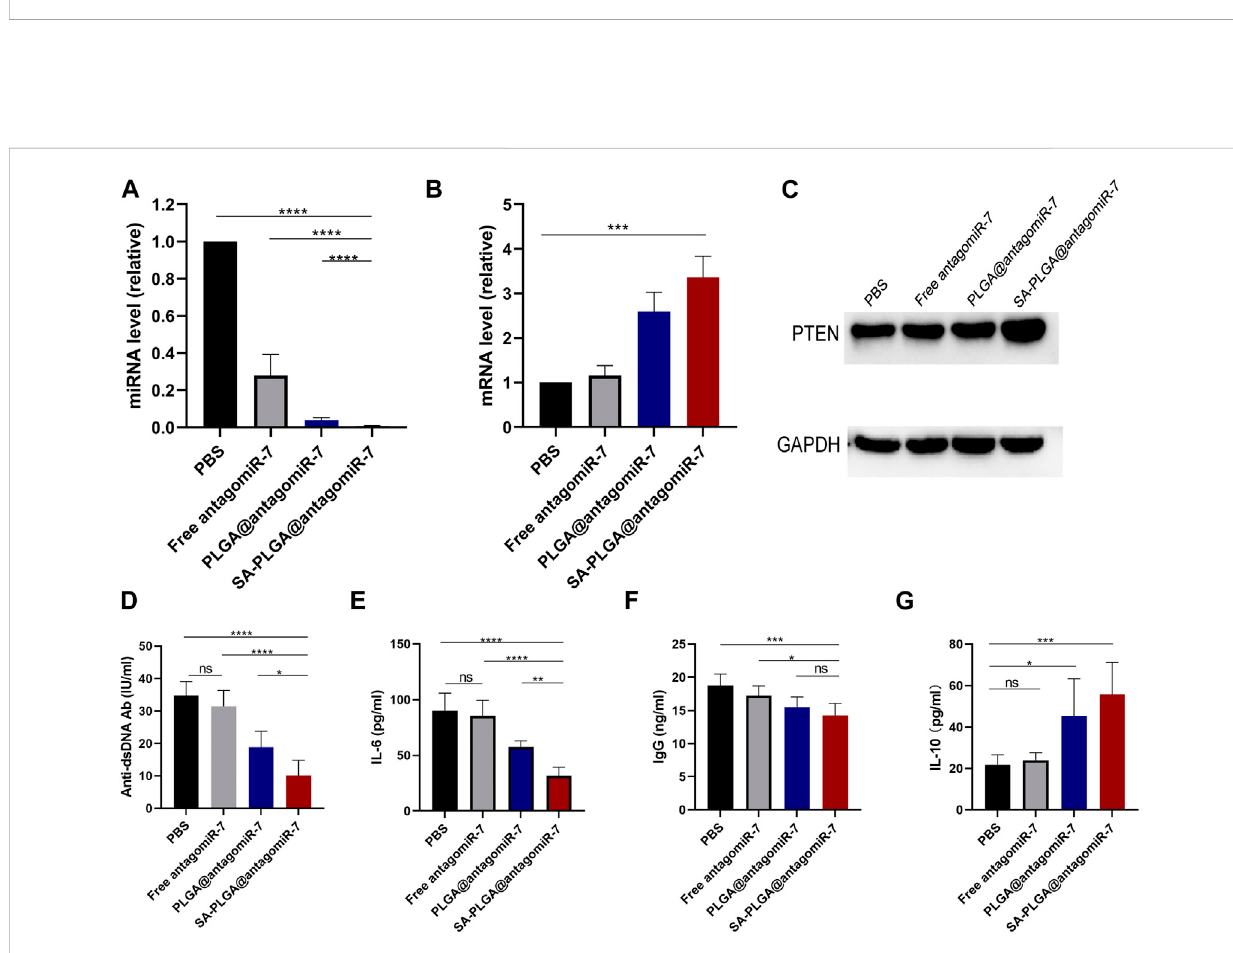
FIGURE 4 (A) Theexpressionlevel ofmiR-7inBcells oflupus micetreatedwithPBS,FreeantagomiR-7,PLGA@antagomiR-7and SA-PLGA@antagomiR-7 was determined by qRT-PCR. They were normalized according to U6 endogenous controls ( n = 3). (B) The expression of PTEN mRNA in B cells was determined by RTqPCR. All PCR reactions werecarried outatleastthree times. (C) Expression levels of PTEN proteininB cellsof lupus mice treated